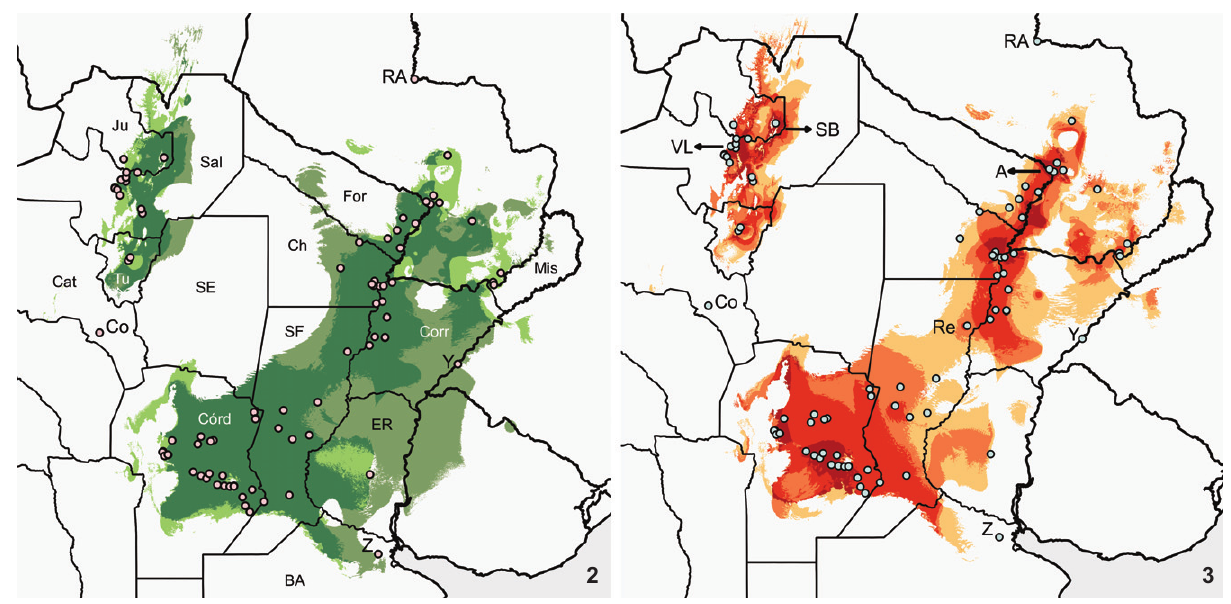
Figures 2-3. Distribution models of Discocyrtus dilatatus , calibrated with the 11 bc selected variables. (2) Overlap of binary models obtained with M AXENT and B IOCLIM (true-false, 1.25). Darker: overlapping areas; lighter: predicted only with M AXENT ; intermediate tone: predicted only with BIOCLIM; Dots: training records. References for selected localities: RA: Río Apa, Co: Concepción, Y: Yapeyú, Z: Zelaya;